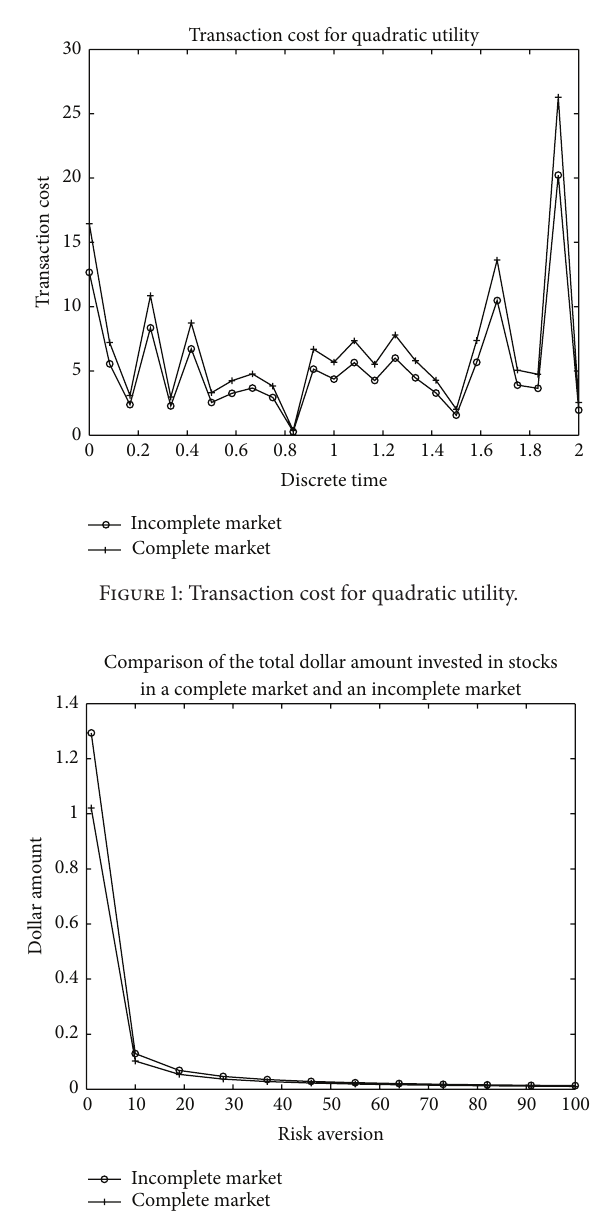
Figure 2: Comparison of the average total dollar amount invested in stocks in a complete market and an incomplete